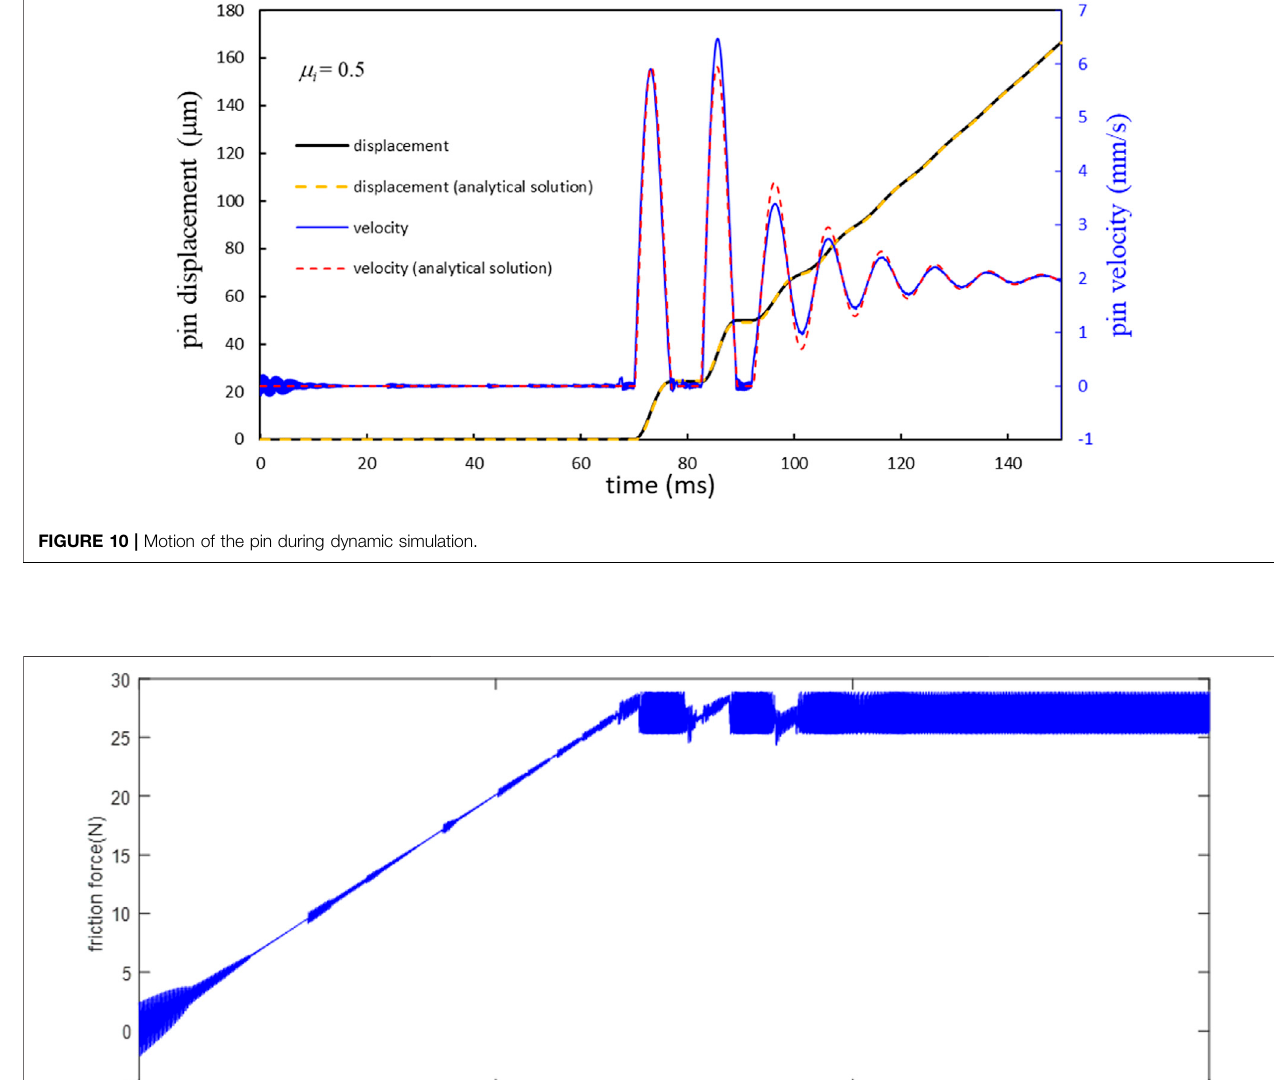
Frontiers in Materials |